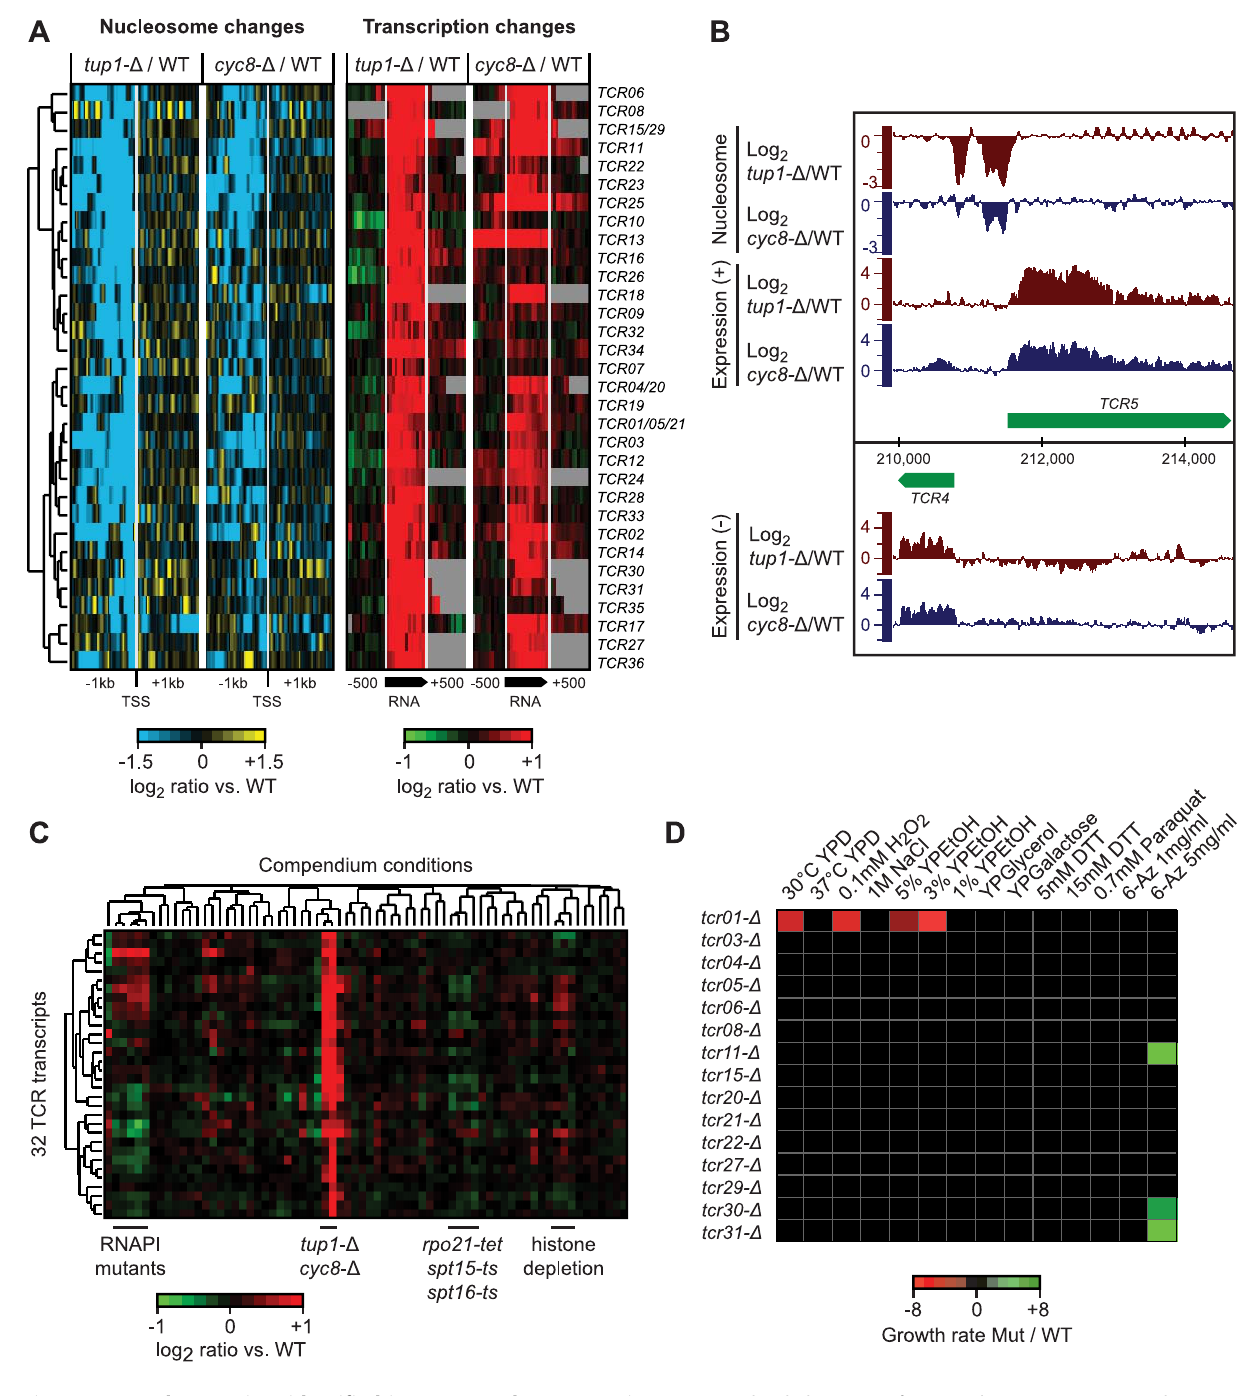
Figure 7. Novel transcripts identified in tup1- D and cyc8- D strains. A) Hierarchical clustering of 36 novel Tup1/Cyc8-repressed transcripts (TCR) showing changes in nucleosome occupancy directly upstream the transcription start site (blue/yellow; left) and expression changes across each transcript and 500 bp intergenic flanking region (red/green; right). The degree of change is indicated by the color bars. B) Example of de-repressed novel transcripts ( TCR4 and TCR5 ) in the tup1- D strain. C) Hierarchical clustering of average expression changes at the 36 TCR loci across all 55 compendium conditions. D) Results of phenotype analysis of 15 tcr deletion mutants in a tup1- D background across a panel of 14 different stress conditions. Growth rates were measured by spot assay and quantified using ImageQuant. Differences in growth rate between tup- D and tup- D /tcr- D strains are indicated by the color bar. doi:10.1371/journal.pgen.1003479.g007 nucleosome-excluding properties of the NDR and confirm that that nucleosome packing is not unidirectional and strongly many of these nucleosomes are not in their optimal intrinsic suggests that genic nucleosomes can and do position themselves positions [28,33,69]. Taken together, our observations indicate independently.